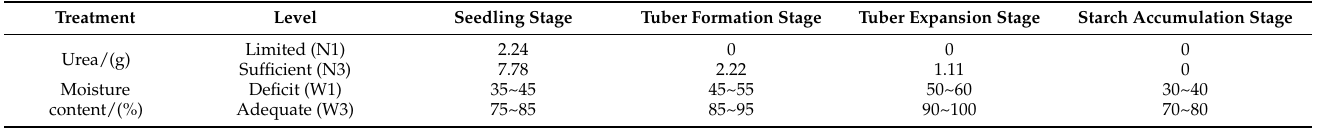
Table 1. Relative water content and amounts of nitrogen applied for potato treatment groups.